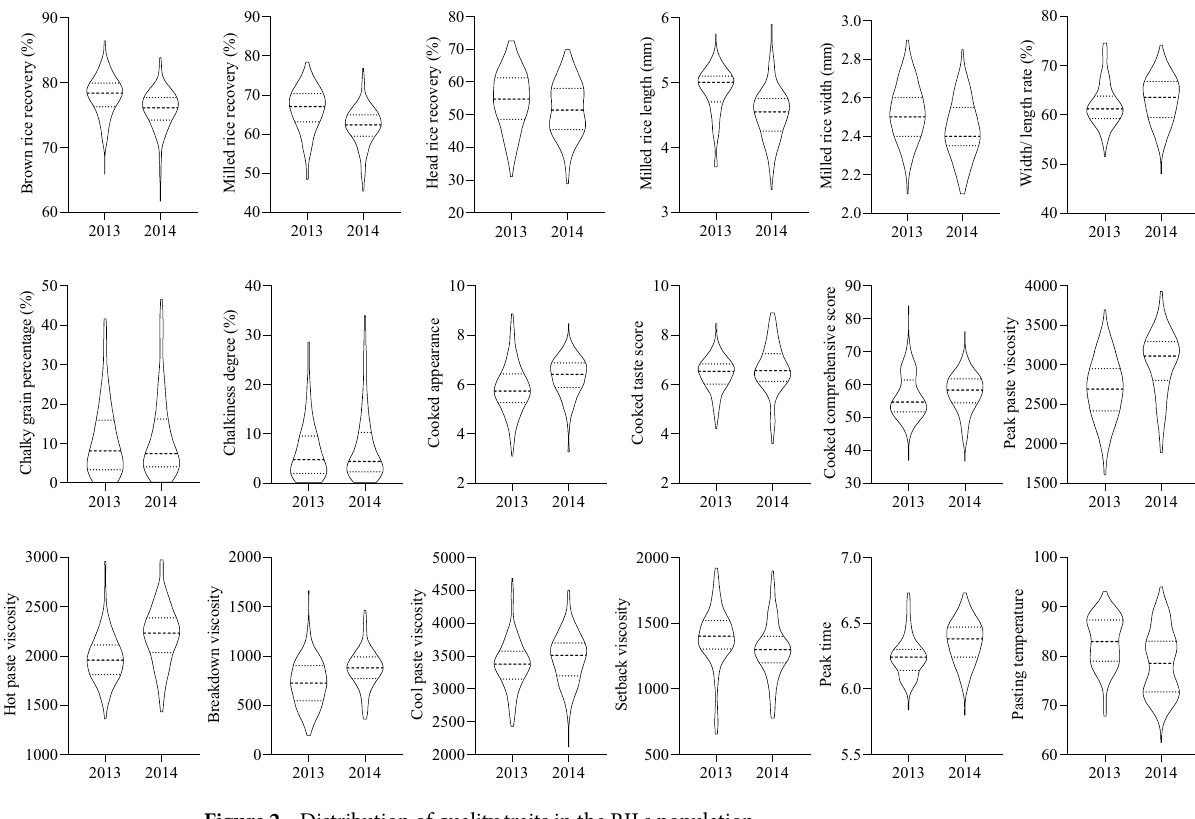
Figure 2. Distribution of quality traits in the RILs population.